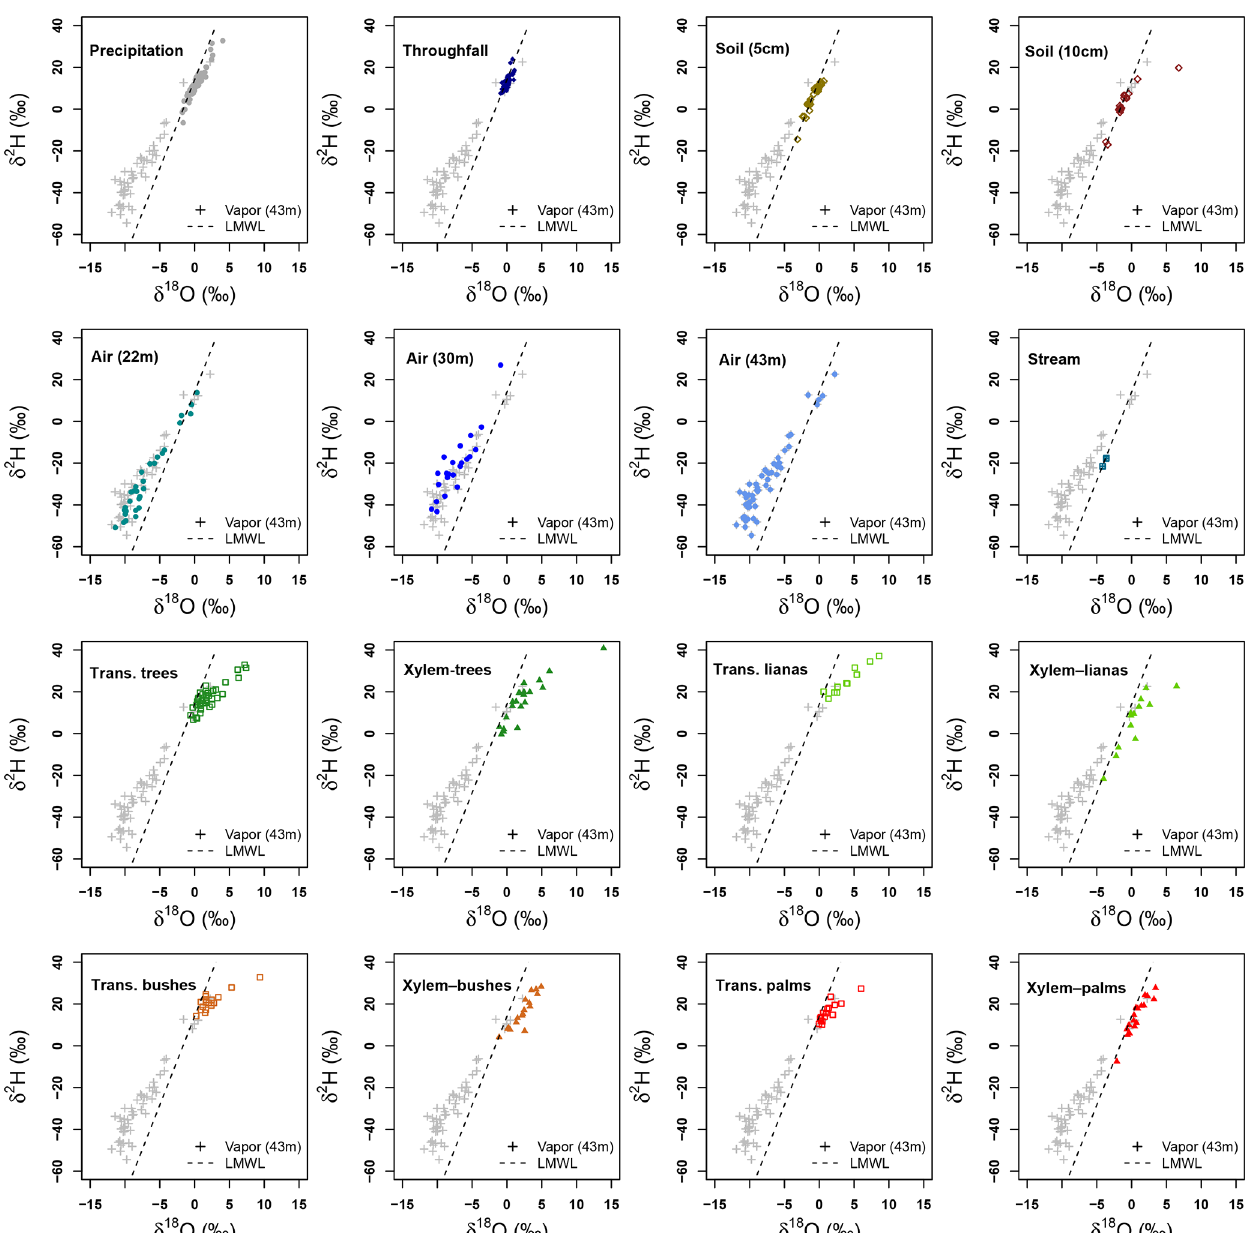
Figure 7. Dual isotope plots of δ 2 H and δ 18 O per sample type collected at La Selva Biological Station. Vapor samples collected at 43m height and local meteoric water line (LMWL) are used in each plot as